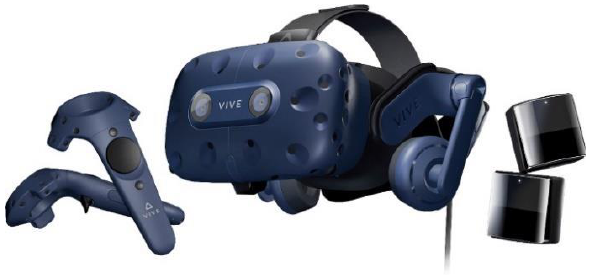
Figure 4. Typical VR workplace with HTC2 glasses and lighthouses.